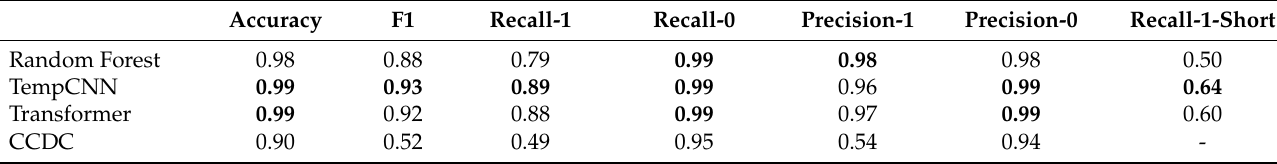
Figure 4. Saliency of temporal regions in time series for pixels in which land cover change is predicted to have occurred, determined using Grad-CAM++. Higher saliency scores indicate that the region is more influential in determining that land cover change has occurred. Blue lines show NDVI, though saliency is calculated using all input features. Black underlines show the period over which the actual land cover change event occurred. In ( a ) a single pixel is shown at four points in time, with each subsequent panel shifted forward one step (10 days). In ( b ) time series from four spatially and temporally independent pixels are shown. Table 1. Model performance evaluated on test data. Recall-1-short reports model recall when change has occurred within the first 2 time steps (20 days), of the 18-step (180 days) time series. Performance of the top-performing model for each metric is highlighted in